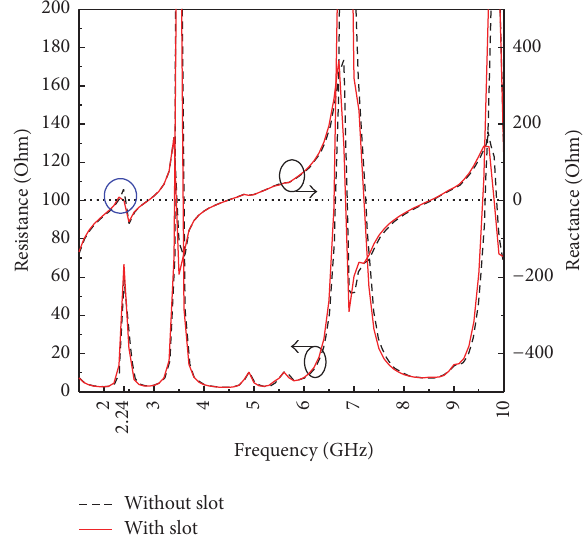
Figure 5: Simulated impedance for proposed antenna with and without